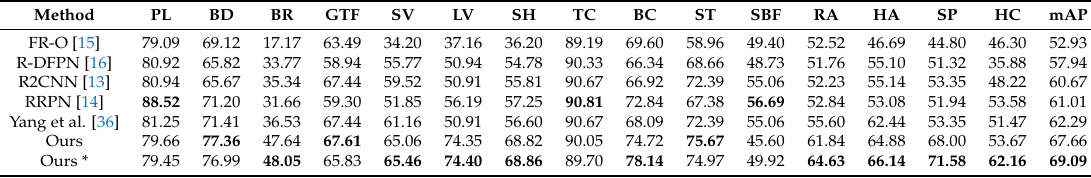
Table 2. Overall performance evaluation of different methods on DOTA datasets. The short names for categories are defined as: PL-Plane, BD-Baseball diamond, BR-Bridge, GTF-Ground track field, SV-Small vehicle, LV-Large vehicle, SH-Ship, TC-Tennis court, BC-Basketball court, ST-Storage tank, SBF-Soccer-ball field, RA-Roundabout, HA-Harbor, SP-Swimming pool, and HC-Helicopter. Ours * indicates the RADet with ResNext101. Bold numbers in Tables means the best